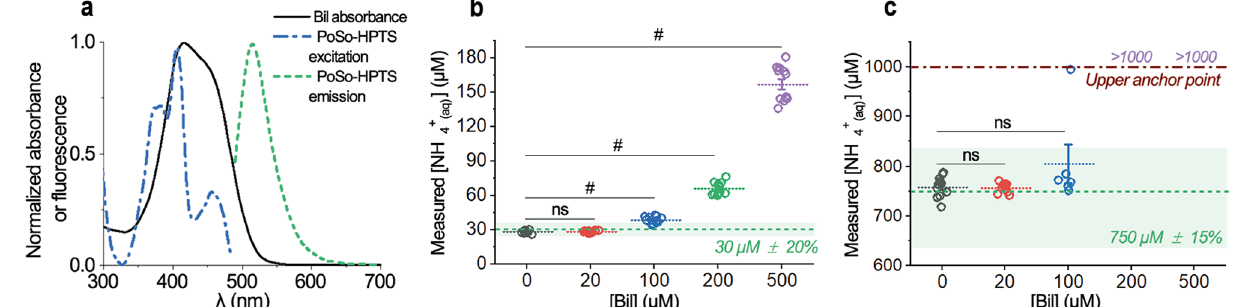
Figure 5. Reducing Bil interference in the PoSo-HPTS ammonia assay. ( a ) Normalized spectra of Bil absorbance and PoSo-HPTS fluorescence excitation (λ em = 515 nm) and emission (λ exc = 455 nm) spectra. ( b–c ) Measured [NH 4+ (aq) ] in the absence and presence of various Bil concentrations in solutions containing 30 μM ( b ) or 750 μM ( c ) NH 4+ (aq) in PBS using PoSo-HPTS with adjusted conditions to reduce Bil interference (i.e. pH in 6.0, pH out 8.2, φ = 40 vol%, [HPTS] in = 2.5 mM, [HPTS] assay = 2.5 µM). Results are shown as exact measured values and mean ± SD. The nominal [NH 4+ (aq) ] with ± 20% ( b ) or ± 15% ( c ) RE is depicted as green dashed line and shaded area. Assay-determined [NH 4 + (aq) ] beyond the upper anchor point are indicated as “> 1000”. Brown- Forsythe and Welch ANOVA (parametric; unmatched) statistical analysis was performed with Holm-Sidak’s multiple comparison tests, where ns and # correspond to p > 0.05 and p ≤ 0.0001,